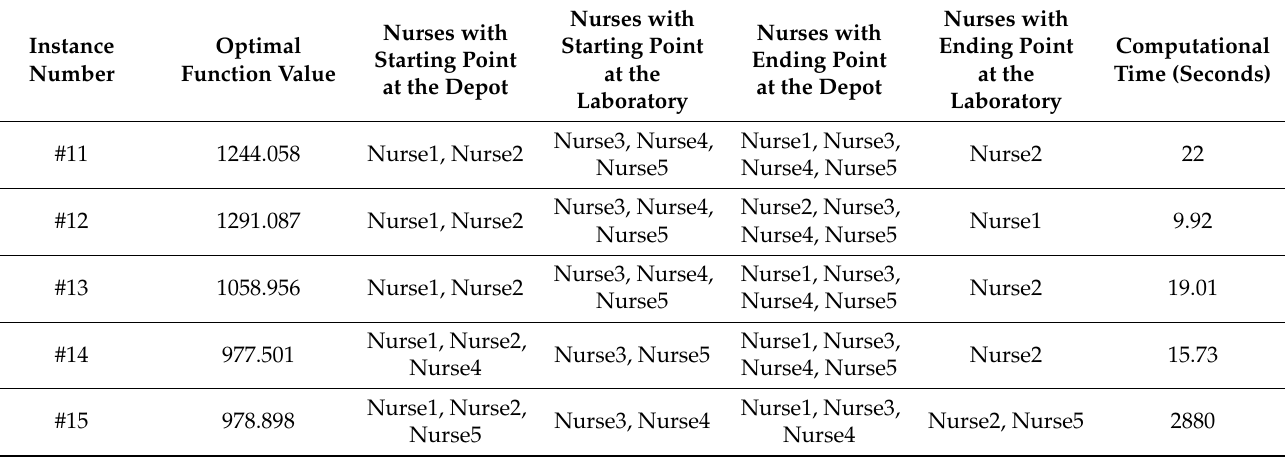
Table 7. The results for the large